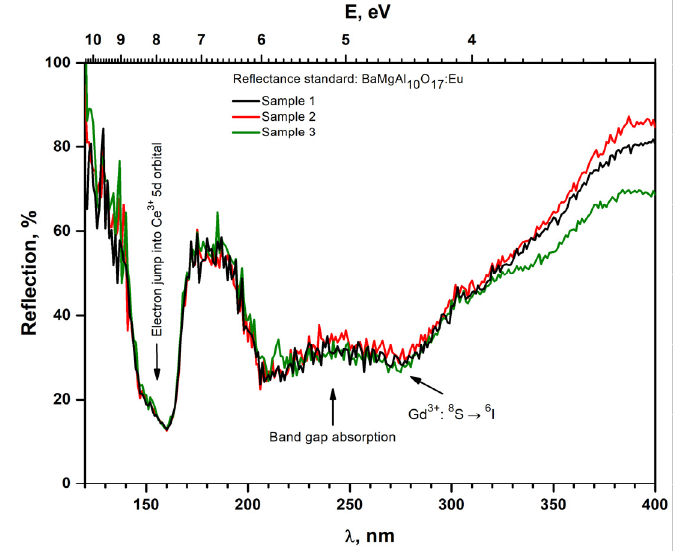
Figure 5. Reflection spectra of GAGG:Ce,Cr,Mg,Ca powder samples in the UV region.